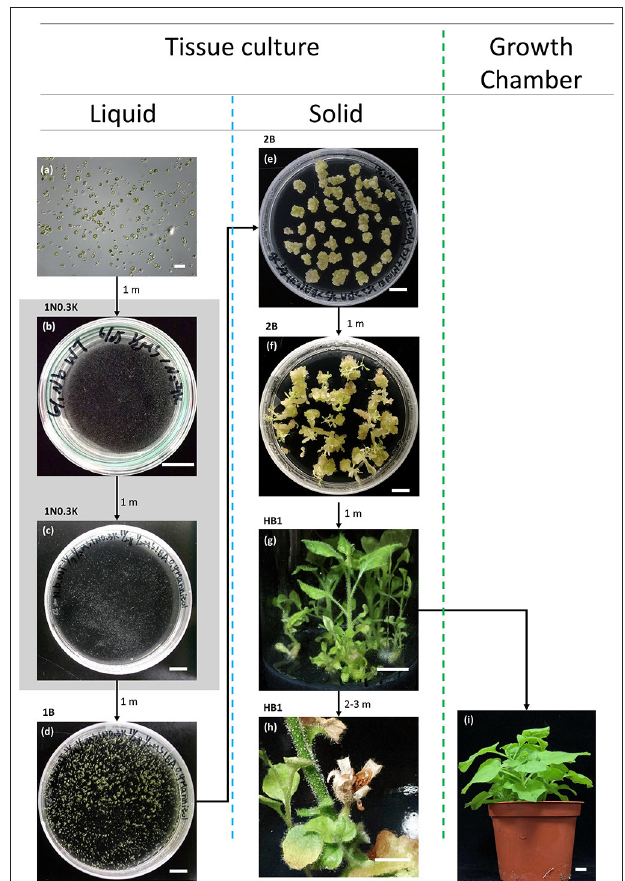
FIGURE 1 | Protoplast regeneration in N. benthamiana . The gray background indicates that the explants were incubated in the dark. All liquid media were supplemented with 0.4M mannitol. The abbreviated names of the media are shown in the top left corner of the images. 1N0.3K: 1/2MS basal medium supplemented with 1 mg/L NAA and 0.3 mg/L kinetin. 1B: ½ MS basal medium supplemented with 1 mg/L BA and 20 g/L sucrose. All solid media were solidified with 7 g/L Phytagel. 2B: 1/2MS basal medium supplemented with 2 mg/L BA. HB1: 3 g/L Hyponex No. 1 (N:P:K = 7:6:19), 2 g/L tryptone, 20 g/L sucrose, and 1 g/L activated charcoal. (a) Transfected mesophyll protoplasts. Bar = 200 µ m. (b) Microcallus formation after 1 month